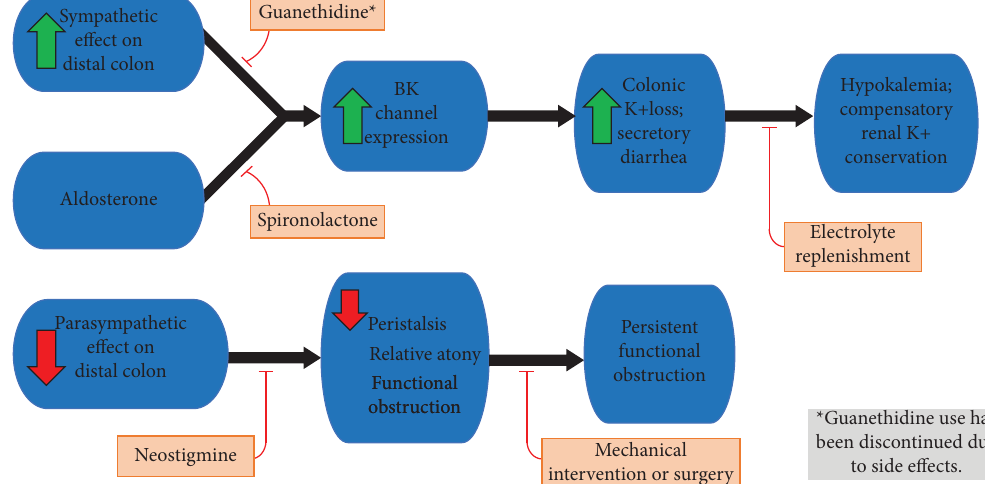
Figure 2: Pathophysiology and treatment options for acute colonic